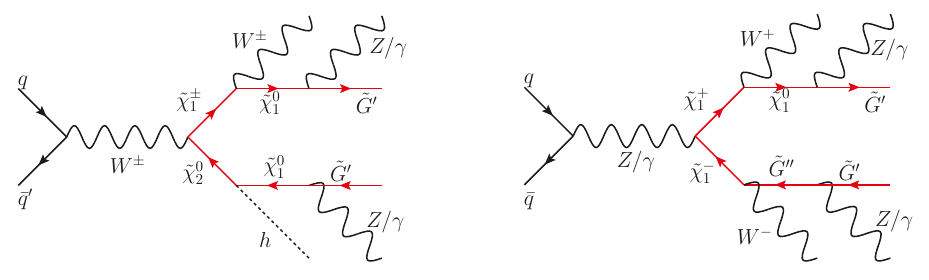
Figure 2 . Typical signal Feynman diagrams with three Z/γ .